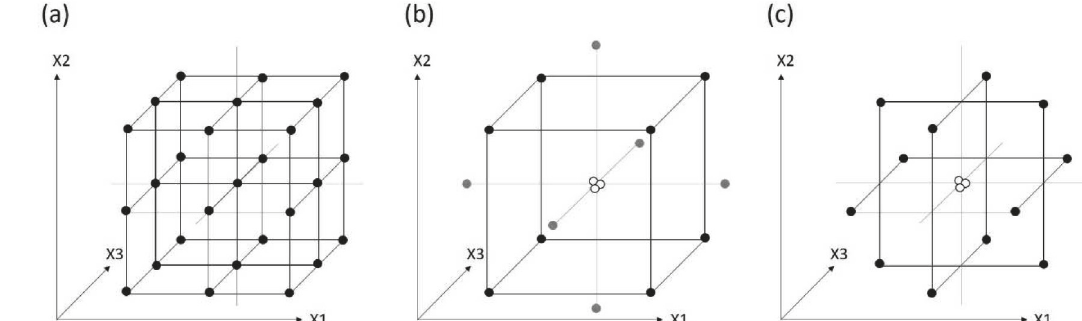
FIGURE 5 – Illustration of three-level full factorial design (3 3 ) matrix (a), central composite design (CCD) matrix (b), and Box- Behnken design matrix (c) for three input